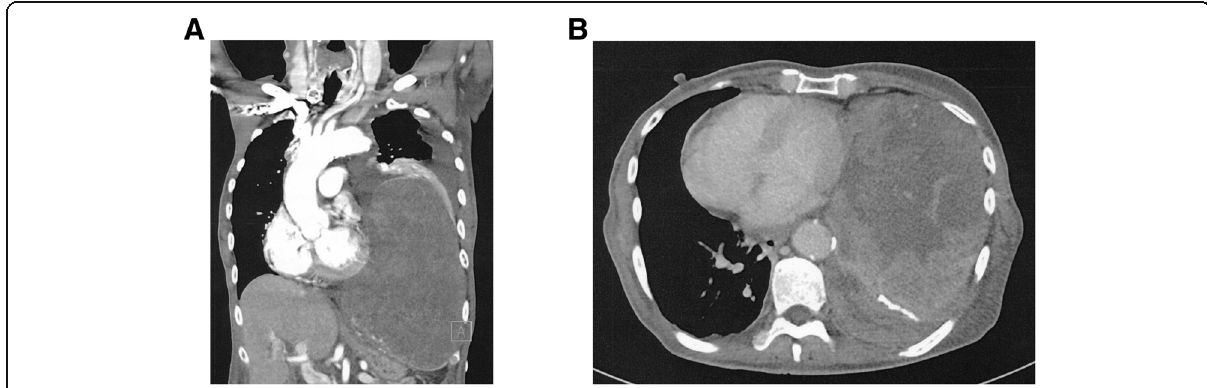
Fig. 1 Preoperative computed tomography scan. a Coronal plane; a giant tumor occupied patient ’ s left pleural cavity and compressed the lung. b Axial